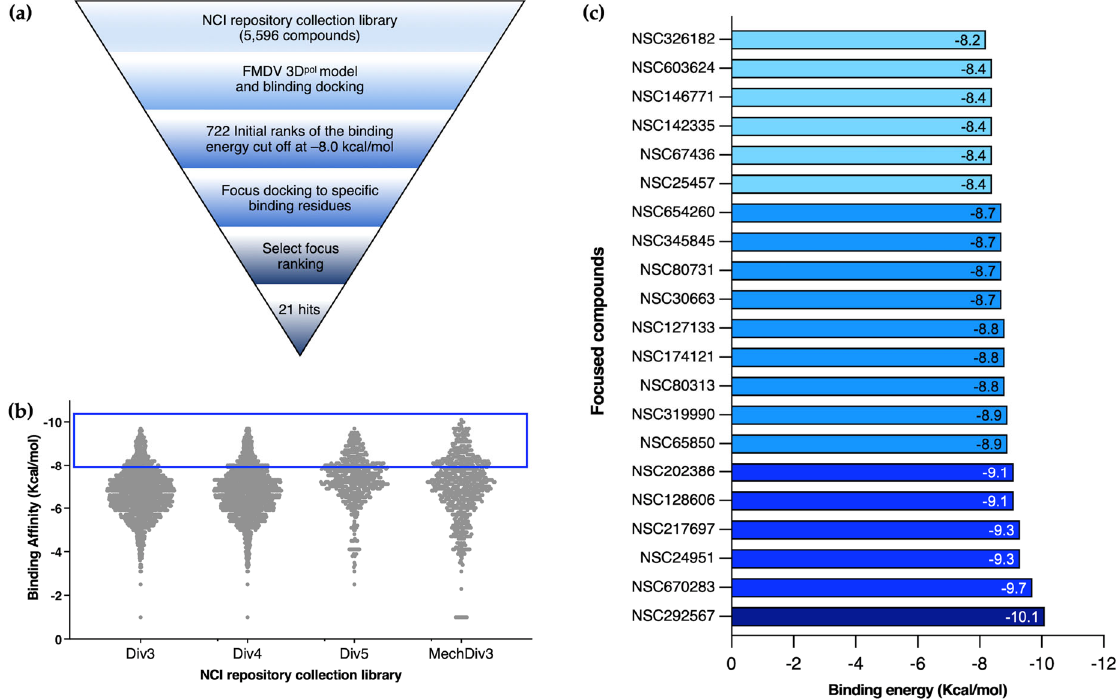
Figure 1. Virtual screening approach in this study. Schematic diagram of virtual screening starting from the initial docking to focus-docking ( a ). The predicted binding affinities of all small molecules, from which the cut-off was set at − 8.0 kcal/mol to filter for the second molecular screening ( b ). The twenty-one top-ranking focal compounds chosen for further cell-based experiments ( c